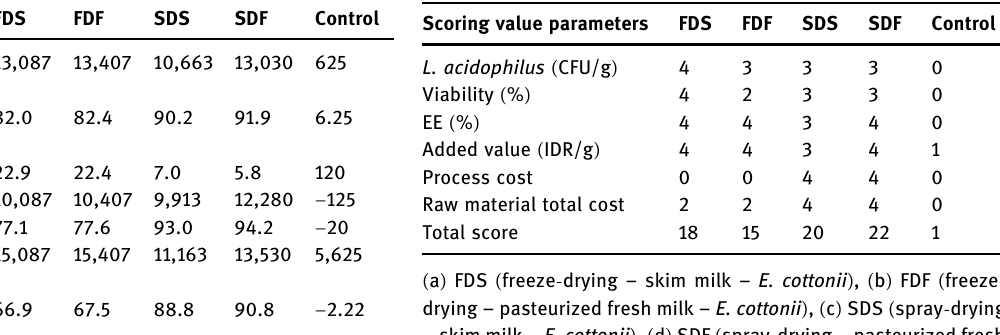
Table 6: The e ff ect of treatment on added value of hydrated L. acidophilus production Parameters FDS FDF SDS SDF